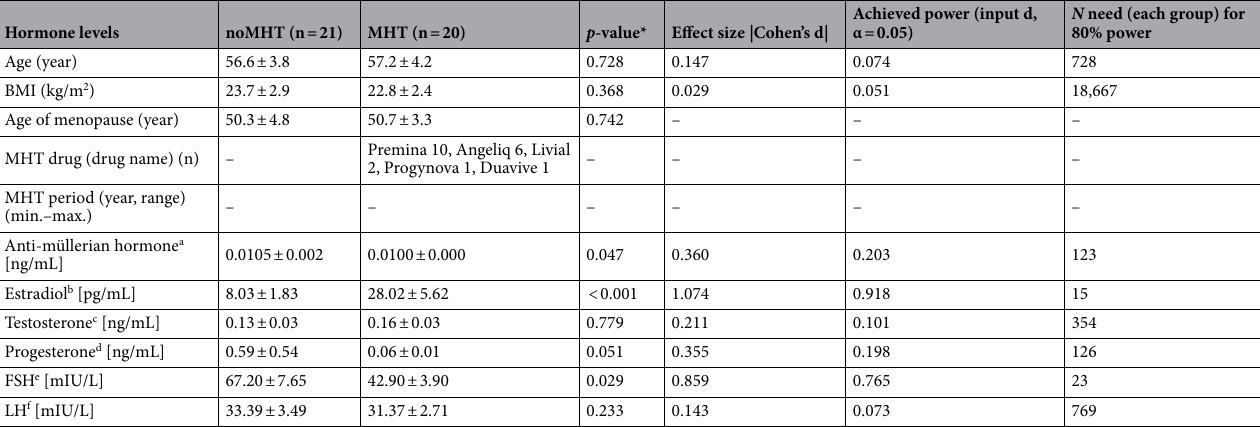
Table 1. Patient characteristics and sex hormone levels in the menopausal hormone therapy (MHT) and noMHT groups. Sex hormone data presented mean ± SEM. BMI: body mass index. MHT stands for menopausal hormone therapy. follicle-stimulating hormone: FSH; and luteinizing hormone: LH. Cohen’s d was calculated for standardized effect size for measuring the difference between two group means. Refer to effect sizes as small (d = 0.2), medium (d = 0.5), large (d = 0.8). Reference ranges for sex steroid hormones in pre- menopausal and post-menopausal women. *The difference between noMHT and MHT groups was analyzed by independent two sample t -test. a High > 4.0 ng/mL; normal 1.5–4.0 ng/mL; low normal 1.0–1.5 ng/mL; low